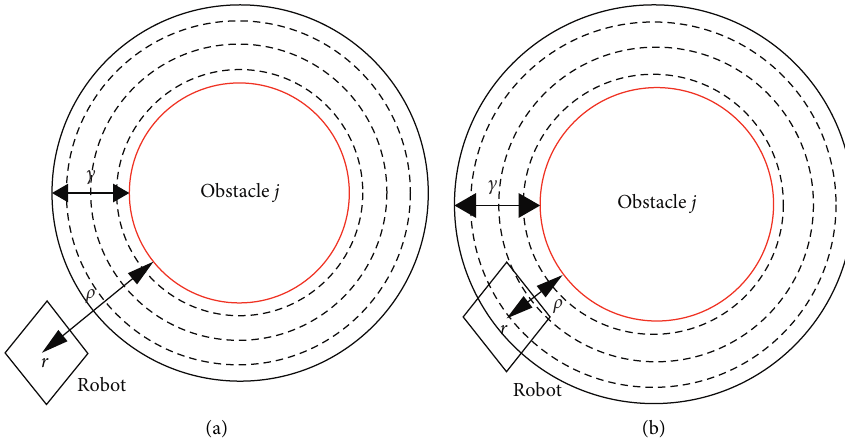
Figure 1: The autonomous movement of the robot in environment with obstacles. Red, black, and dotted circles represent obstacles, the boundary of the influence range of obstacle, and obstacle field distribution. (a) The robot is outside influence range of obstacle. (b) The robot is inside influence range of obstacle.